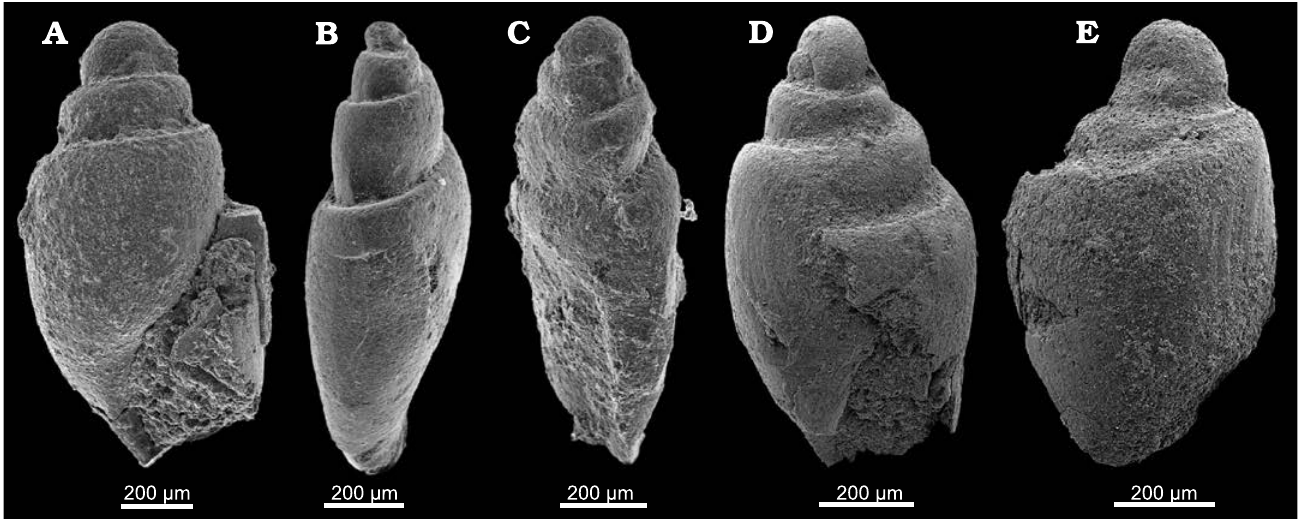
Fig. 25. Heterobranch gastropods from Lago Antorno (A–C) and from Misurina Landslide (D, E), northern Italy, Cassian Formation, Carnian, Upper Triassic. A . Sinuarbullina sp. 1, PZO 12850, in apertural view. B . Sinuarbullina sp. 3, PZO 12852, in lateral view. C . Sinuarbullina sp. 3, PZO 12853, in lateral view. D . Sinuarbullina sp. 1, PZO 12736, in apertural view. E . Sinuarbullina sp. 2, PZO 12738, in lateral